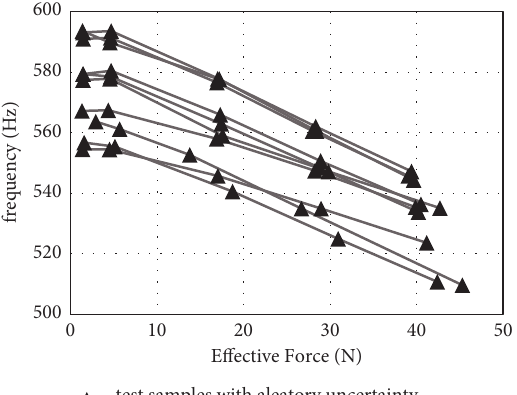
Figure 18: The natural frequency results from modal test using 10 groups of different isolators under 5 different excitation